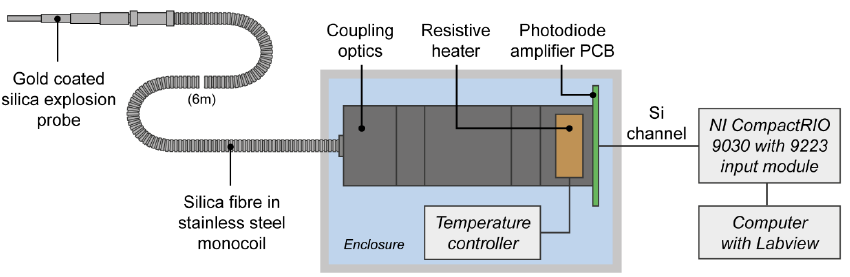
Figure 1. Overview of IRT and data acquisition system.